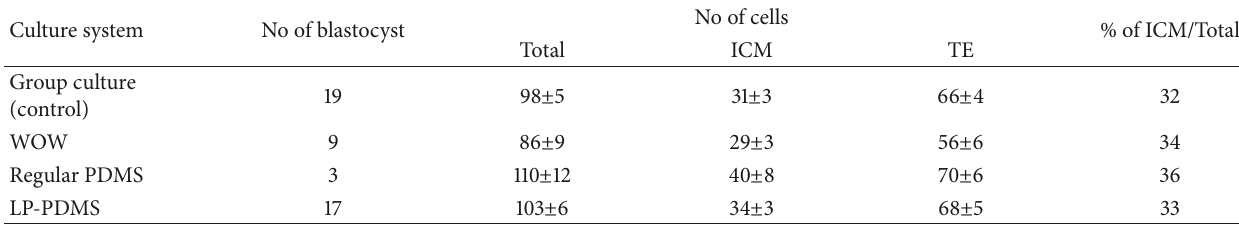
Table 2: Cell number of blastocysts cultured with PDMS